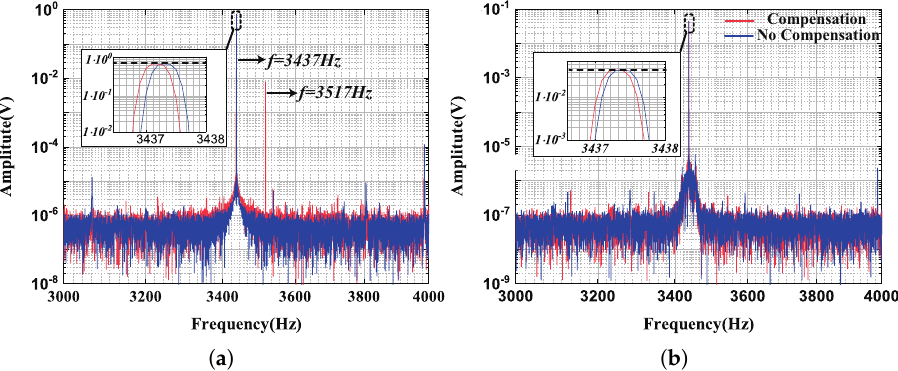
Figure 12. ( a ) The frequency spectrum of detection signal in drive mode. ( b ) The frequency spectrum of feedback force signal in sense mode.